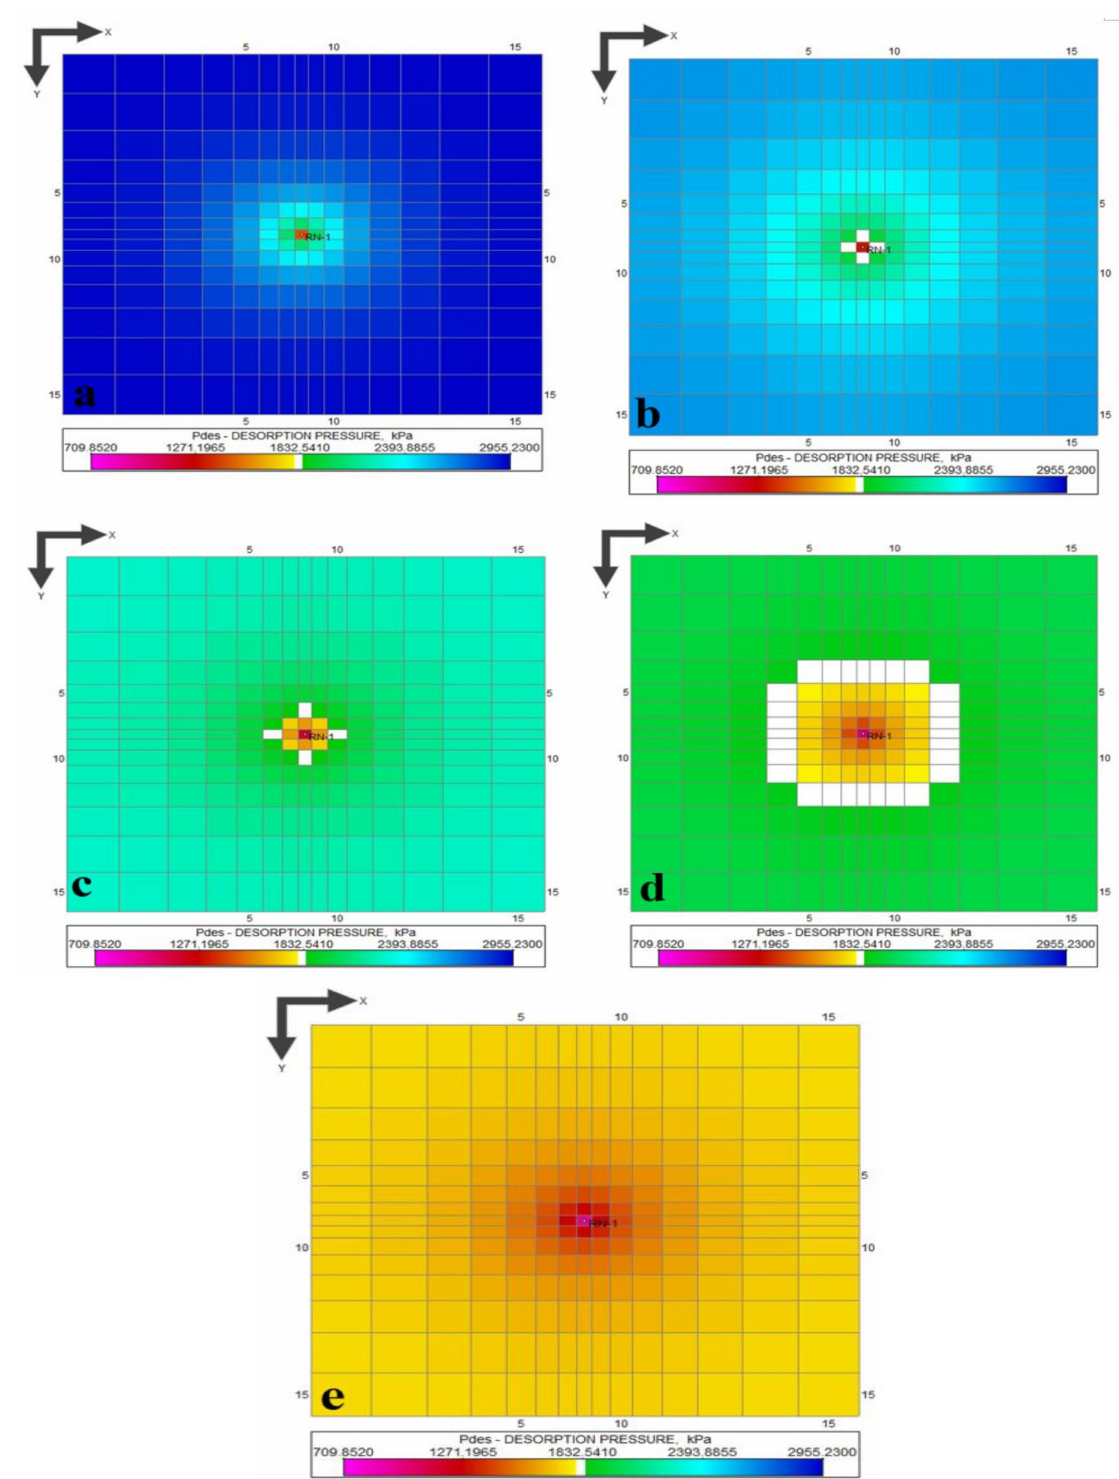
Figure 6. ( a – e ). Effect of water production on desorption pressure the area over a period of 1000 days, 3000 days, 5000 days, 7000 days and 9000 days, respectively. The plots of cumulative water and water production rate from the vertical well desig- nated show that the rate of water production is slightly high for starting days. It is observed in the field that water production increases at an incline speed constantly monitored